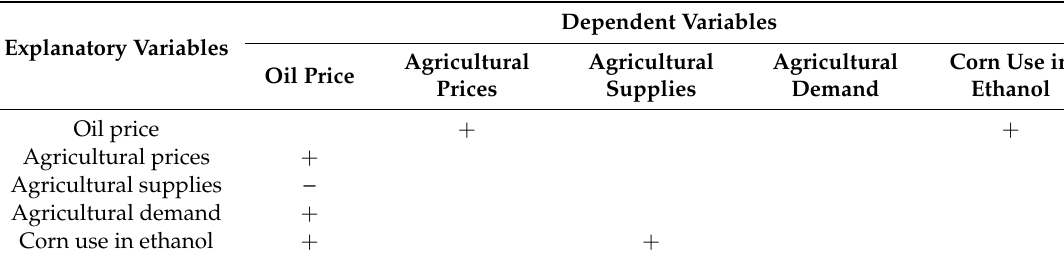
Table 6. Summary of